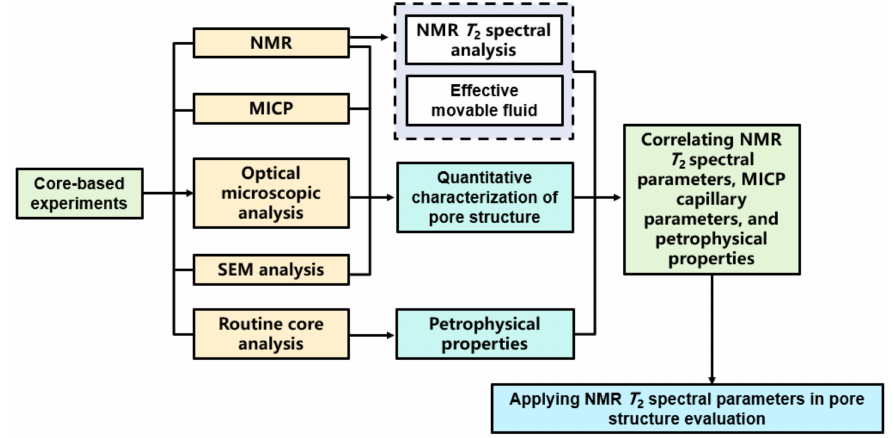
Figure 2. Workflow used for pore structure